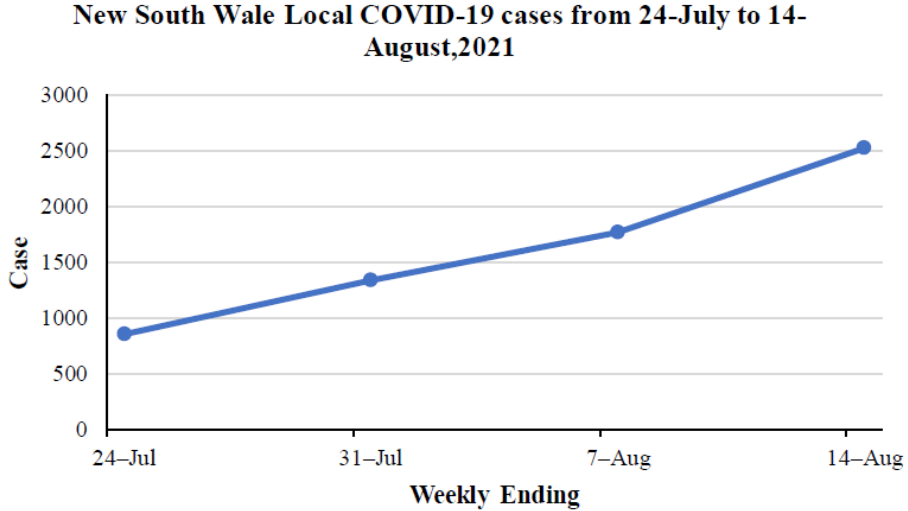
Figure 5. New South Wales local COVID-19 cases from 7 to 14 August 2021 (accessed 14 August 2021) [66].